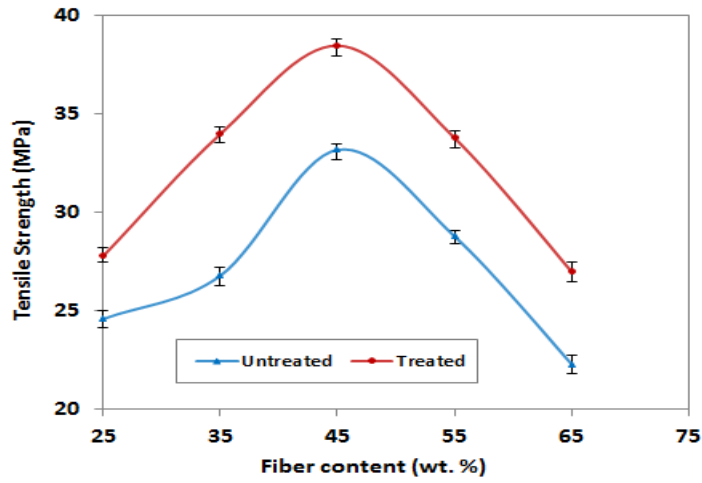
Figure 4: Comparative tensile strength of the resultant composites with respect to fiber loading.